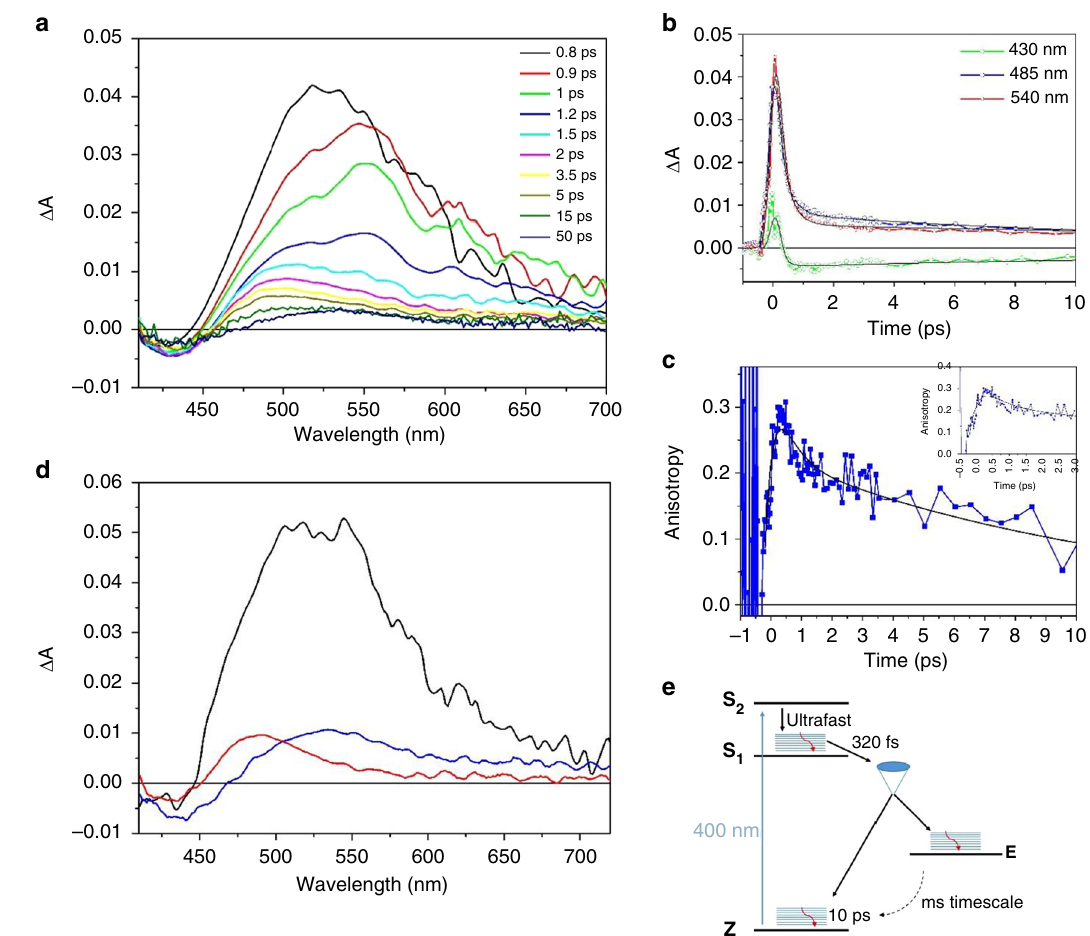
Fig. 4 Ultra-fast Transient Spectroscopy of ITI. a Transient absorption spectra of unsubstituted ITI 1a recorded in methanol with excitation at 400 nm. b Representative kinetic traces (open symbols) and fi ts obtained from target analysis (continuous line), c Time-resolved anisotropy, the initial 3 ps are shown in the inset, d Species-Associated Decay Spectra (SADS), obtained by analyzing the kinetic traces with the kinetic model depicted on the right- bottom side of the fi gure. The black curve represents the S 1 state, the red curve hot Z isomer and the blue curve the E isomer. e Proposed model for